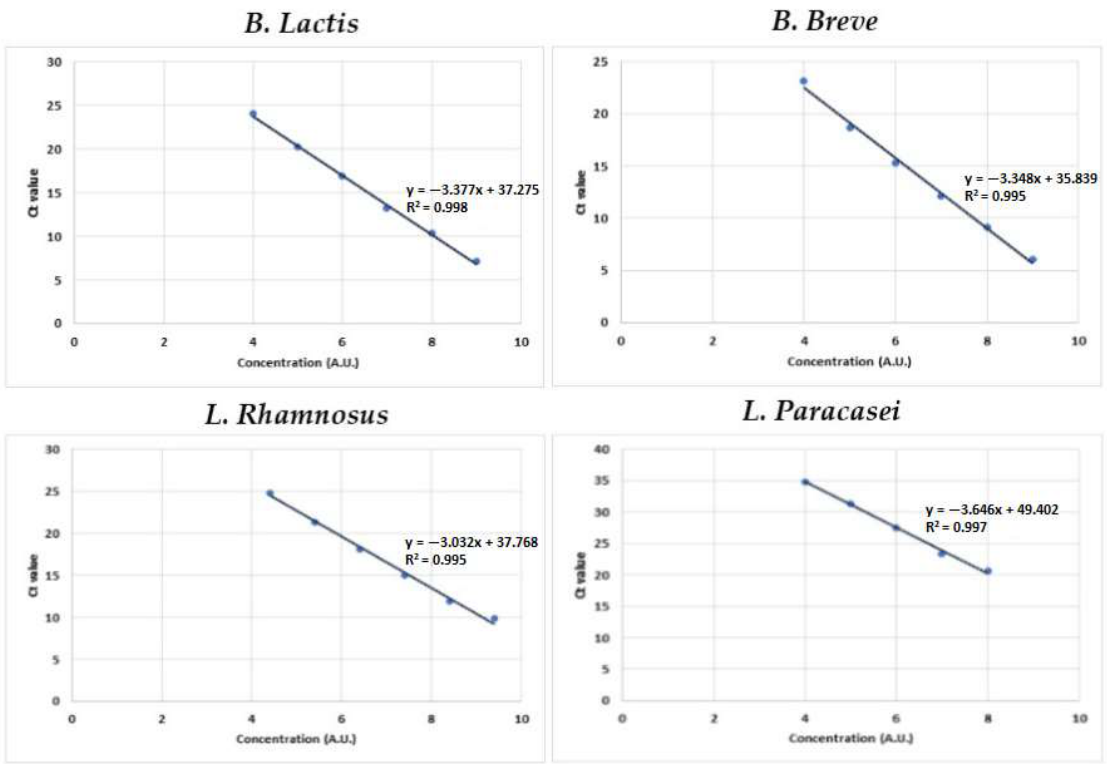
Figure 4. Constructed standard curves imported into different qPCR runs and used for the quantification of DNA copies from unknown extracted samples of food supplement 2. The curves were obtained by plotting the mean values of the Log-calculated concentration of known samples versus the cycle threshold value (Ct). A.U.: Arbitrary Units; qPCR: quantitative polymerase chain reaction. Table 8. Count results by RT-qPCR of food supplement 2 expressed as Log10 for Lactobacillus rhamnosus and Lactobacillus paracasei .